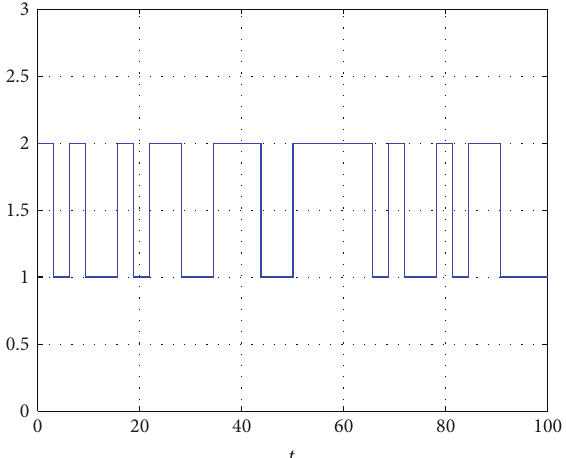
Figure 2: Switching signal 𝜎(𝑡) with minimum dwell time 𝛿 1 = 3 .